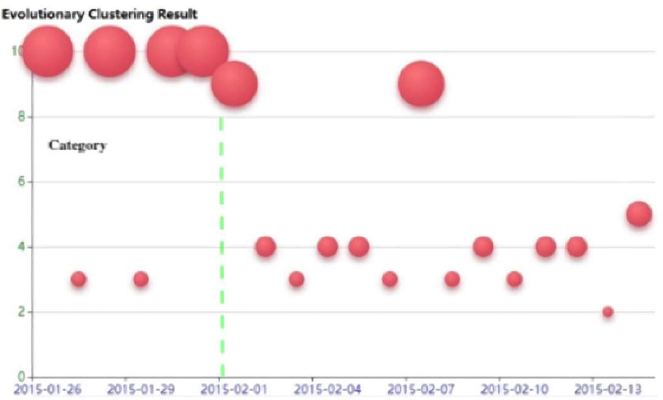
Figure 16. Evolutionary clustering result on a certain user.